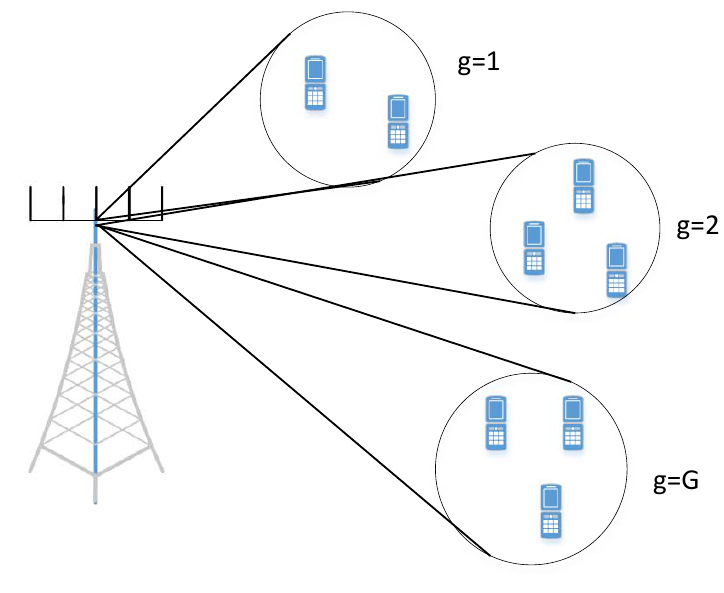
Figure 2. System